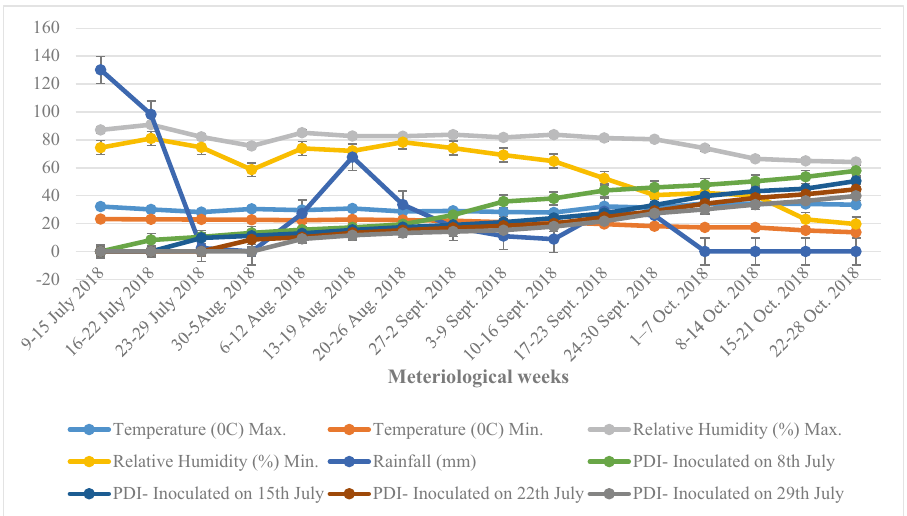
Figure 1. Progression of Alternaria leaf spot on soybean in relation to weather parameters in different dates of sowing under epiphytotic conditions during Kharif